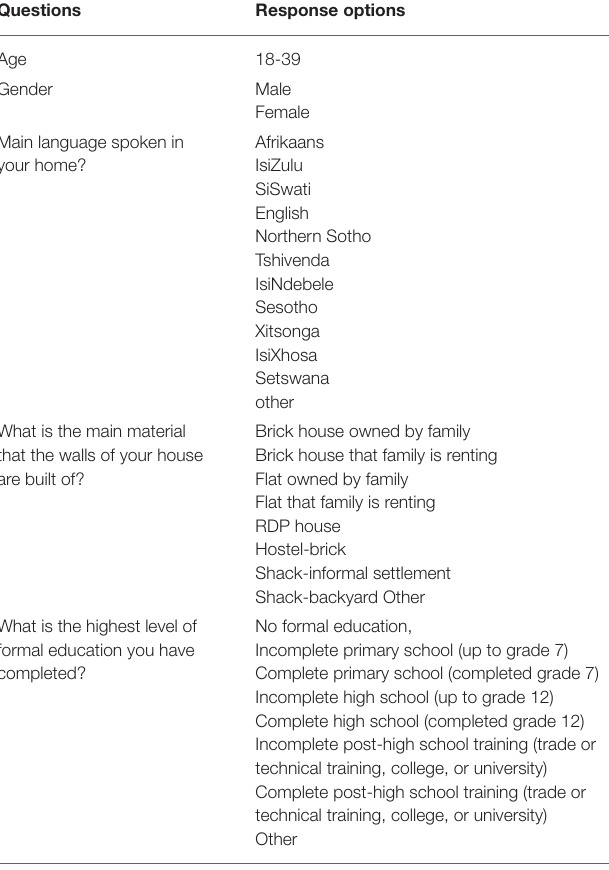
TABLE 1 | Socio-demographic